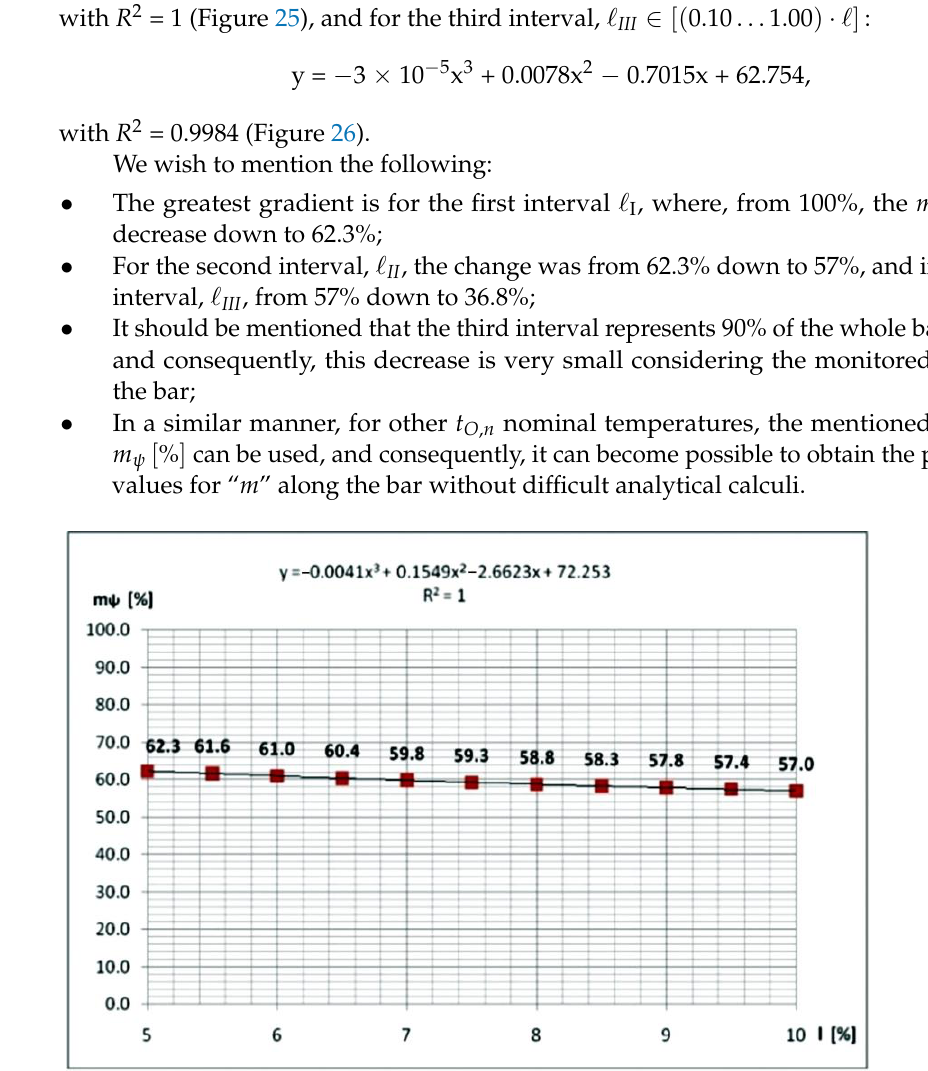
  100050 .   100050 . II II